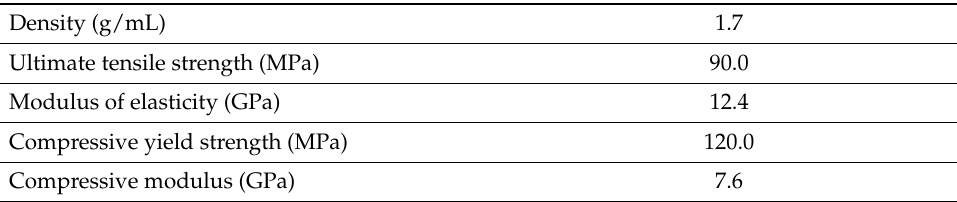
Table 1. Physical and mechanical properties of the synthetic cortical bone.